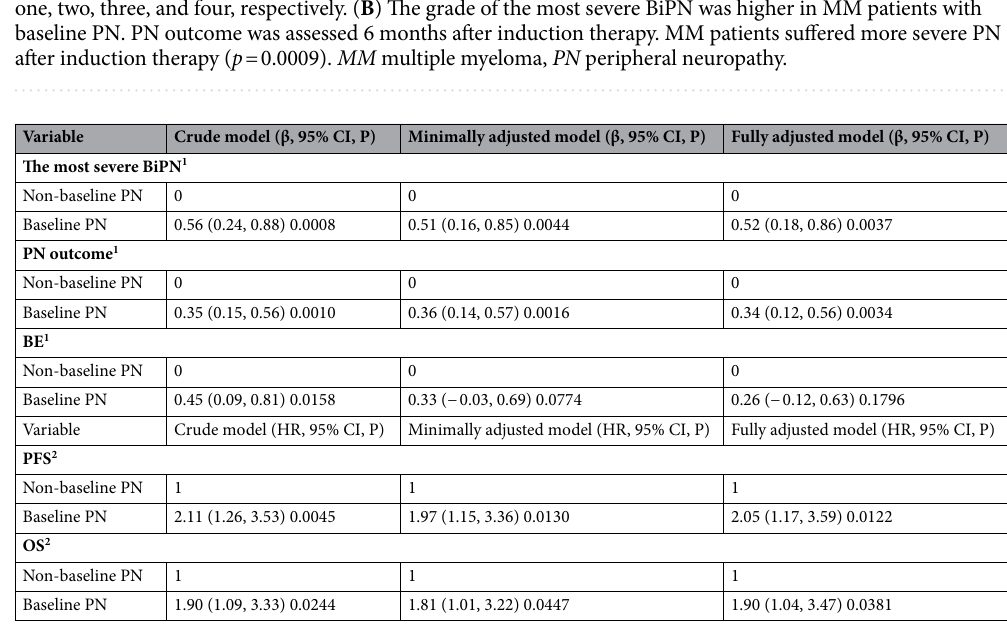
Figure 4. Violin plot showed PN grades between different baseline PN groups (created by GraphPad Prism 8). ( A ) MM patients with baseline PN suffered more severe bortezomib-induced peripheral neuropathy (BiPN) in bortezomib-based inductive regimen ( p = 0.0008). PN1, PN2, PN3, and PN4 were acronyms for BiPN in cycles one, two, three, and four, respectively. ( B ) The grade of the most severe BiPN was higher in MM patients with